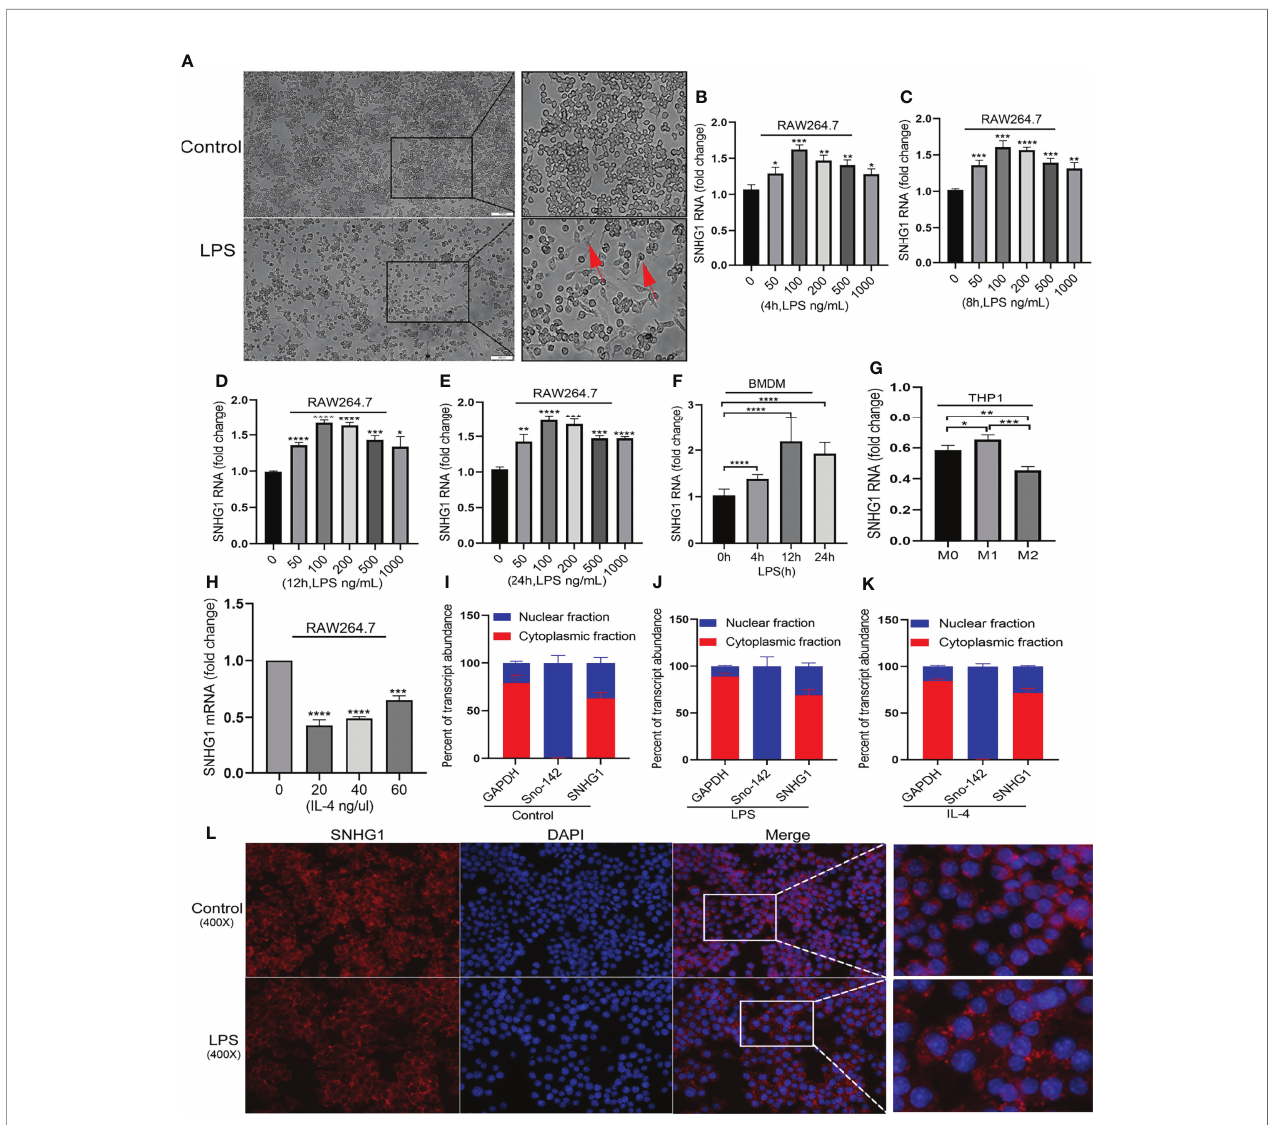
FIGURE 1 | Distinctly expressed lncRNA-SNHG1 in differentially activated macrophages. (A) The morphology of RAW264.7 cells was signi fi cantly changed after LPS stimulation (magni fi cation, ×100, scale bar, 100 m m). (B – E) The expression of SNHG1 in RAW264.7 cells treated with an LPS concentration gradient for 4 h, 8 h, 12 h, and 24 h. (F) Mouse BMDMs were treated with 100 ng/ml LPS for the indicated duration of time. Total RNA was isolated, and the levels of SNHG1 were determined by qRT-PCR. (G) Human THP-1-derived macrophages were treated with PMA, human IFN-r and IL-4 for the indicated times. Levels of SNHG1 were determined. (H) RAW264.7 cells were treated with a concentration gradient of mouse IL-4 for 24 h. Levels of SNHG1 were determined. (I – K) qRT-PCR was used to measure the level of SNHG1 in the nucleus and cytoplasm of RAW264.7 cells treated with PBS, LPS and IL-4. (L) FISH was performed to observe the cellular location of expression of SNHG1 (red) in RAW264.7 cells and in LPS induced-RAW264.7 cells (magni fi cation, ×400, scale bar, 20 m m and magni fi cation, ×1000, scale bar, 10 m m). The data between two groups were compared using unpaired t-tests. Data are indicated as the mean ± SD, *P <0.05, **P <0.01, ***P <0.001, ****P